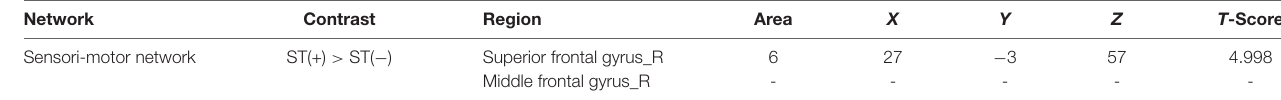
TABLE 5 | Different regions within the SMN between ST(+) and ST( − ) patients. Network Contrast Sensori-motor network